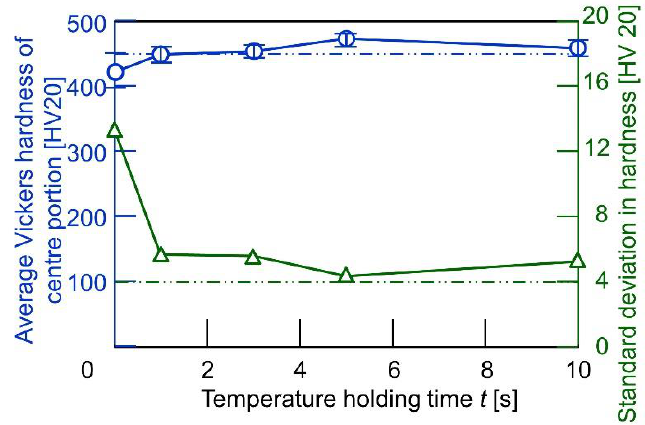
Figure 16. Effect of temperature holding during austenitising on Vickers hardness and standard deviation in hardness for v = 275 °C/s.